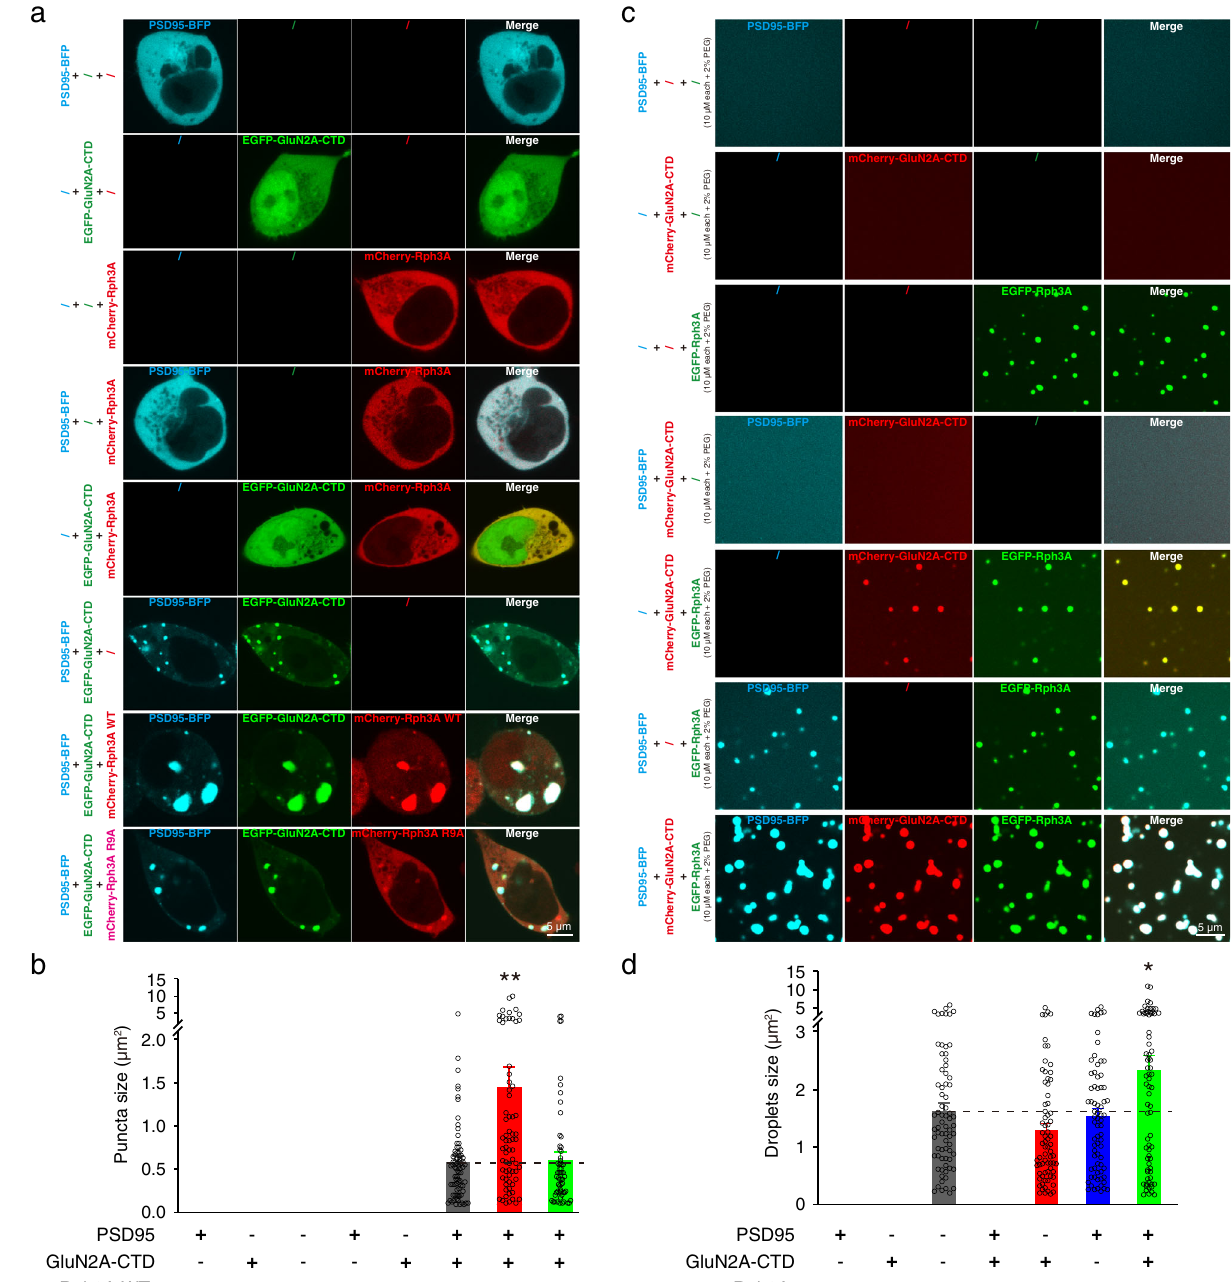
Fig. 5 | The GluN2A/PSD95 complex promotes the phase separation of Rph3A. a RepresentativeimagesofHEK293cellstransfectedwithdifferentcombinationsof PSD95,GluN2A-CTD,WT,andR9ARph3A. b Sizesofpunctacomposedofdifferent combinations of the proteins in A. The data are displayed as the mean±SEM (PSD95/GluN2A-CTD: n =78puncta;PSD95/GluN2A-CTD/Rph3AWT: n =73puncta; PSD95/GluN2A-CTD/Rph3A R9A: n =66 puncta, ** p <0.01, one-way ANOVA fol- lowed by Tukey ’ s multiple comparisons test). c Representative images of droplets